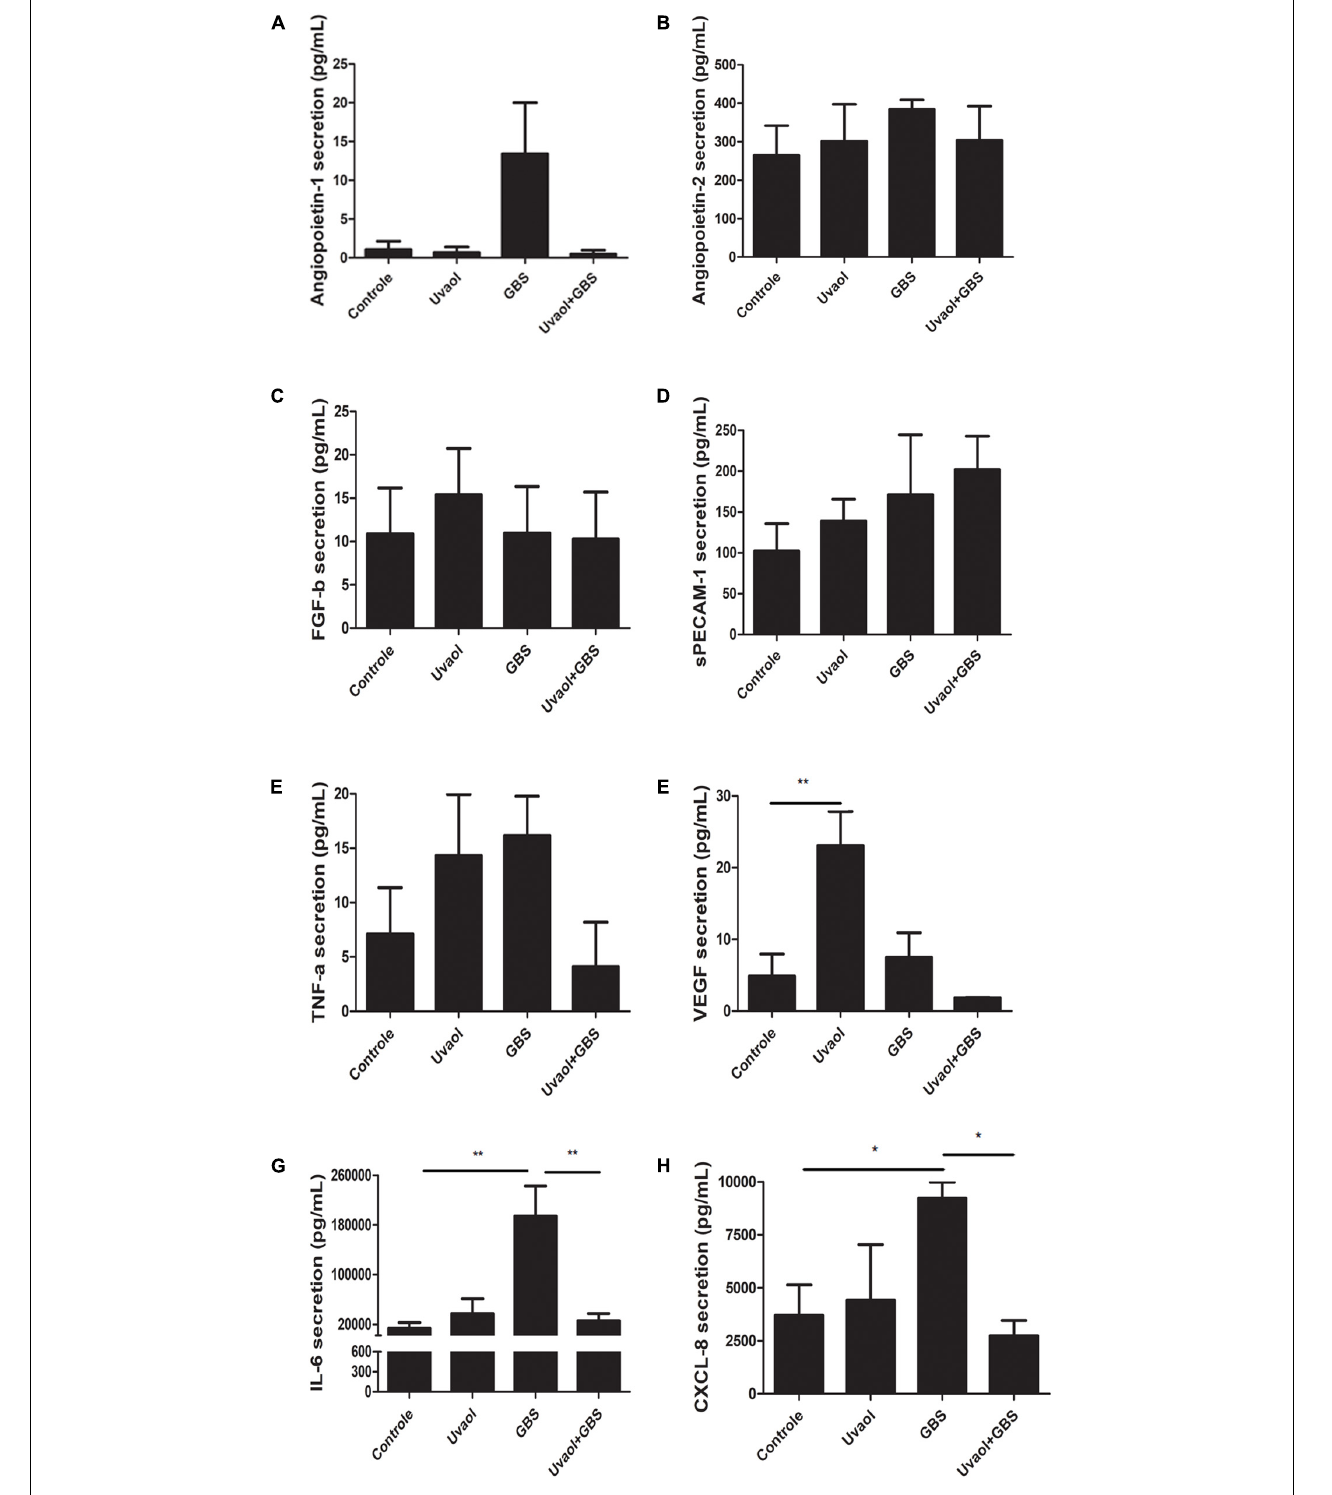
FIGURE 7 | Vasoactive factors secretion by term chorionic villi explants. The supernatants from the term chorionic villi explants were collected and analyzed for angiopoietin-1 (A) , angiopoietin-2 (B) , FGF-b (C) , sPECAM-1 (D) , TNF- α (E) , VEGF (F) , IL-6 (G) , and CXCL-8 (H) through flow cytometry. The analyzed groups were composed by control, added with 50- µ M uvaol or GBS at 1 × 10 6 CFU, or both (uvaol + GBS). A bar graphs represent mean values ± S.E.M.; n = 5 in duplicate. *, p < 0.05; **, p < 0.01.